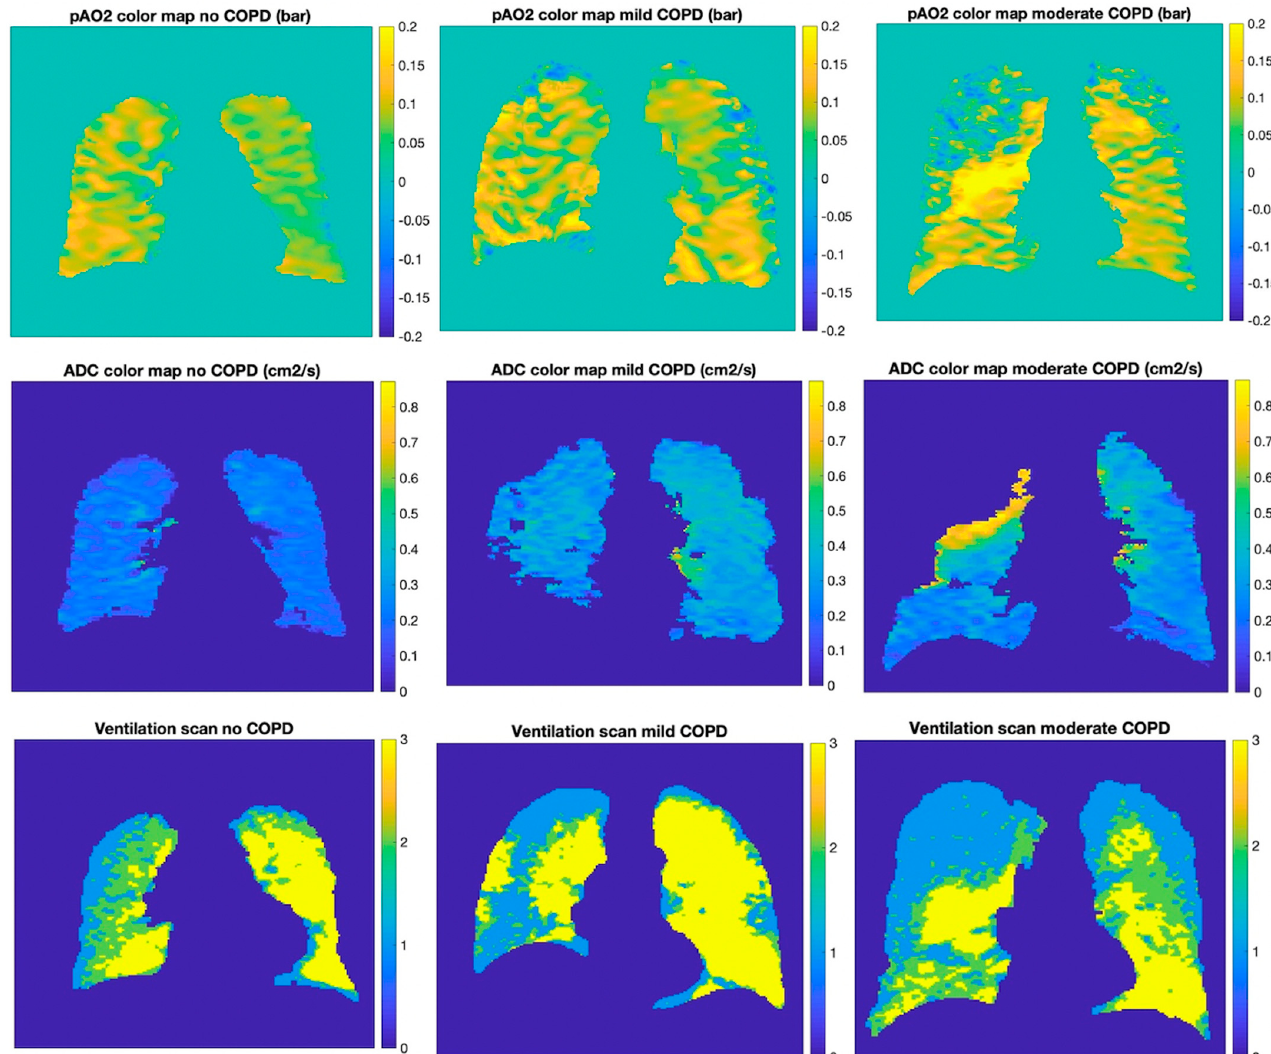
Figure 2. Color maps of three subjects with different levels of disease severity. Left column: subject with no COPD, center column: mild COPD, right column: severe COPD; from top to bottom: p A O 2 color map, ADC color map, ventilation scan. On the ventilation scans blue corresponds to non-ventilated regions, green hypo-ventilated and yellow normal.